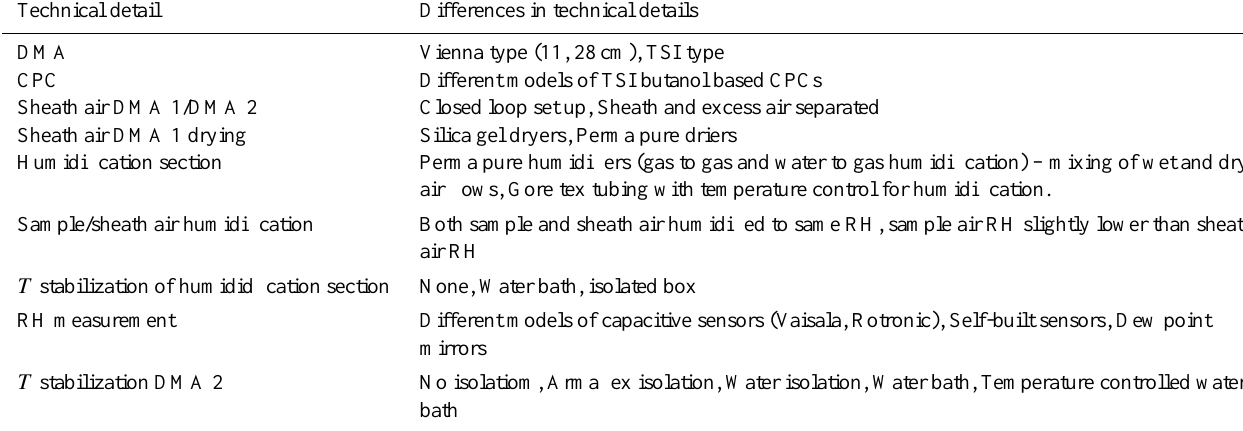
Table 1. Differences in technical details of operated H-TDMA systems during the comparison.